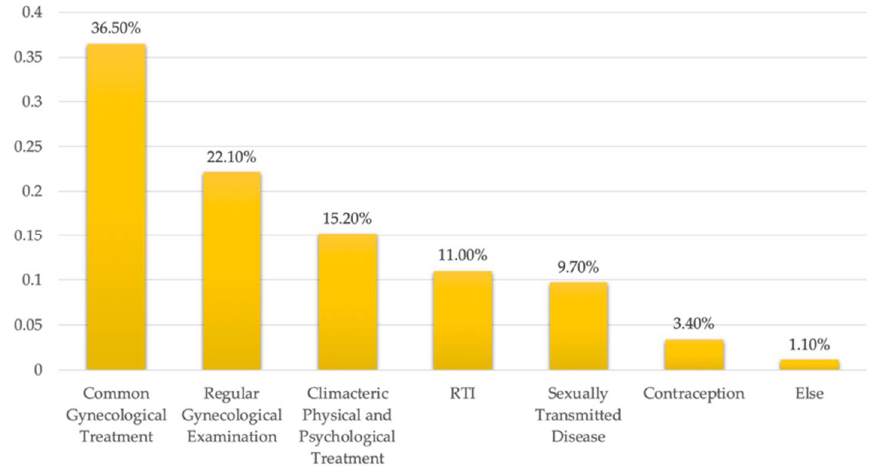
Figure 6. Different healthcare requirements of women in Yuetan Area.